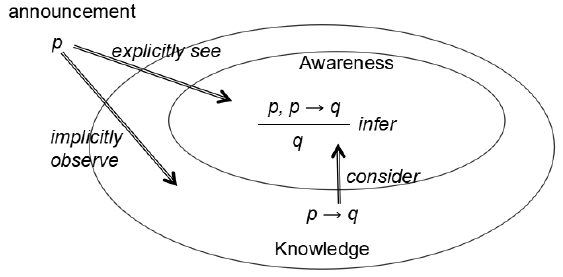
Fig. 1. The model of inference process of an